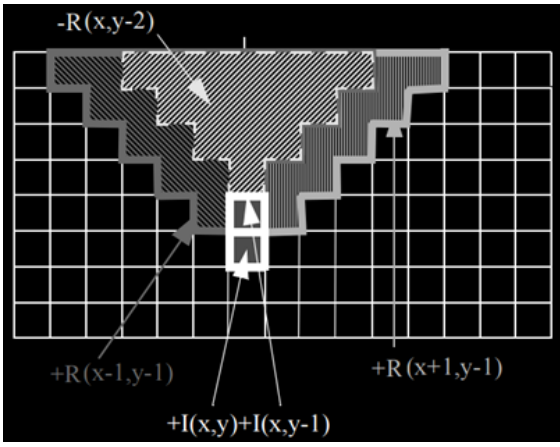
Figure 10. Calculation scheme for the integral image.